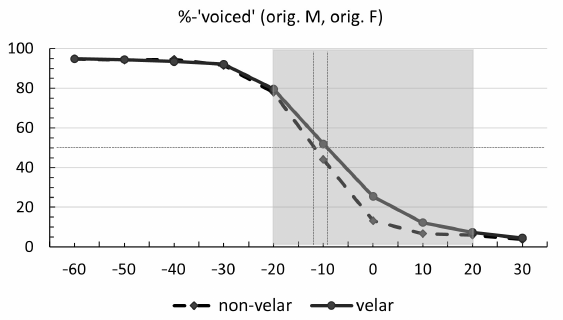
Figure 2. Identification curves for the original voice non-velars (dashed line) and velars (solid line) identified as ‘voiced’ across 10 VOT levels. Thin dotted lines mark the 50% boundary. Statistical modeling was conducted on the area highlighted in